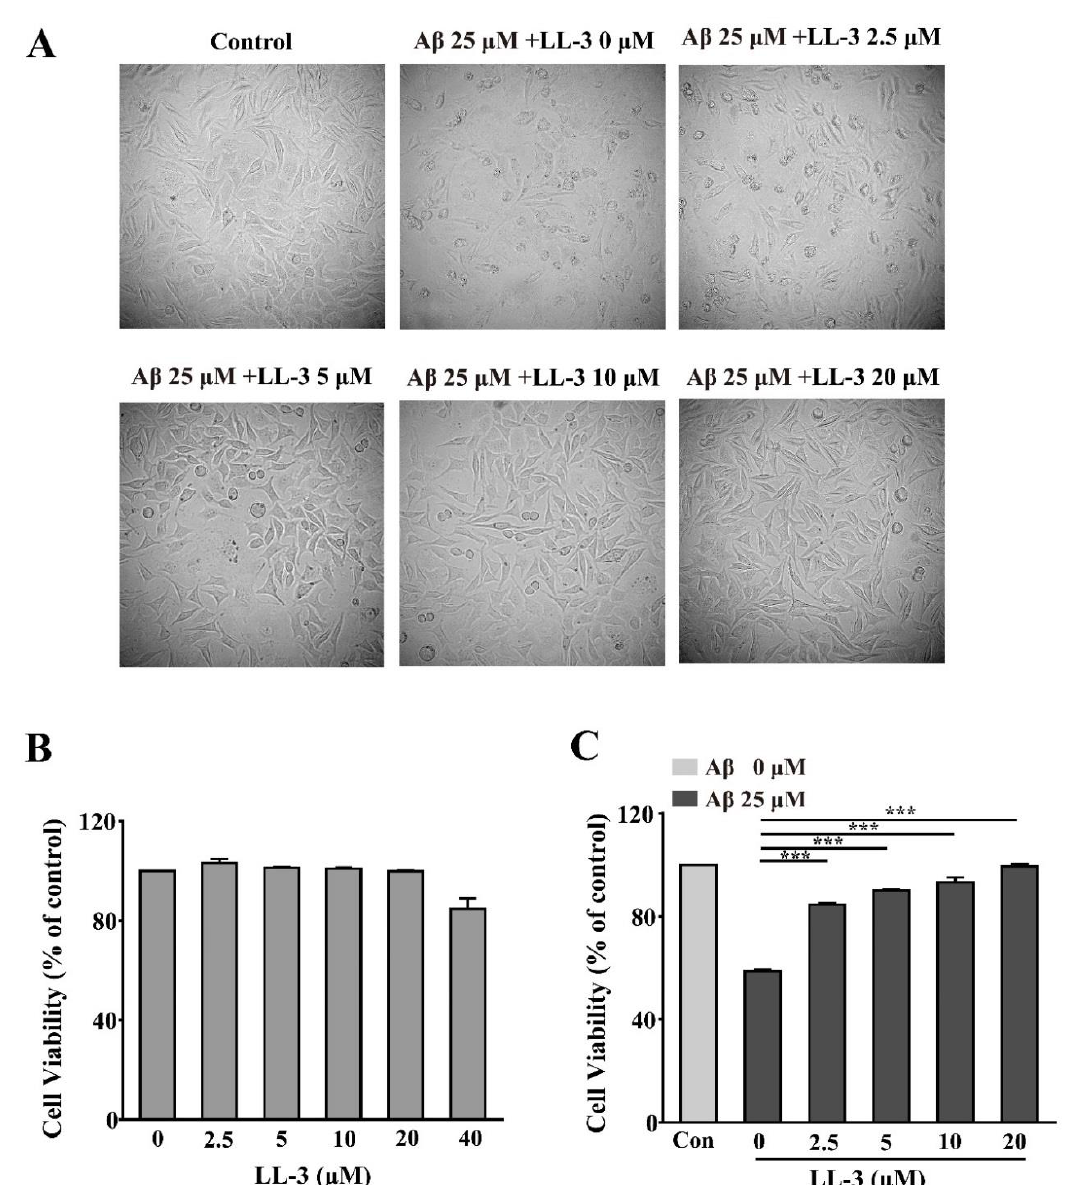
Figure 2. LL-3 protective e ff ect on amyloid beta peptide 25-35 (A β 25-35 )-induced neurotoxicity in SH-SY5Y cells. SH-SY5Y cells were treated with di ff erent concentrations of LL-3 for 48 h and then cell viability was analyzed according to 3-(4,5-dimethyl-2-thiazolyl)-2,5-diphenyl-2-H-tetrazolium bromide (MTT) assay by measuring the absorbance at 570 nm ( B ). SH-SY5Y cells were treated with di ff erent concentrations of LL-3 for 30 min prior to 25 µ M A β 25-35 for another 48 h. After this incubation, cell viability was determined using the MTT assay ( C ) and LL-3 co-incubated with A β 25-35 e ff ect on cell viability was viewed under microscope ( A ). All these experiments were detected three times and shown with mean ± SD and *** p < 0.001 compared to A β 25-35